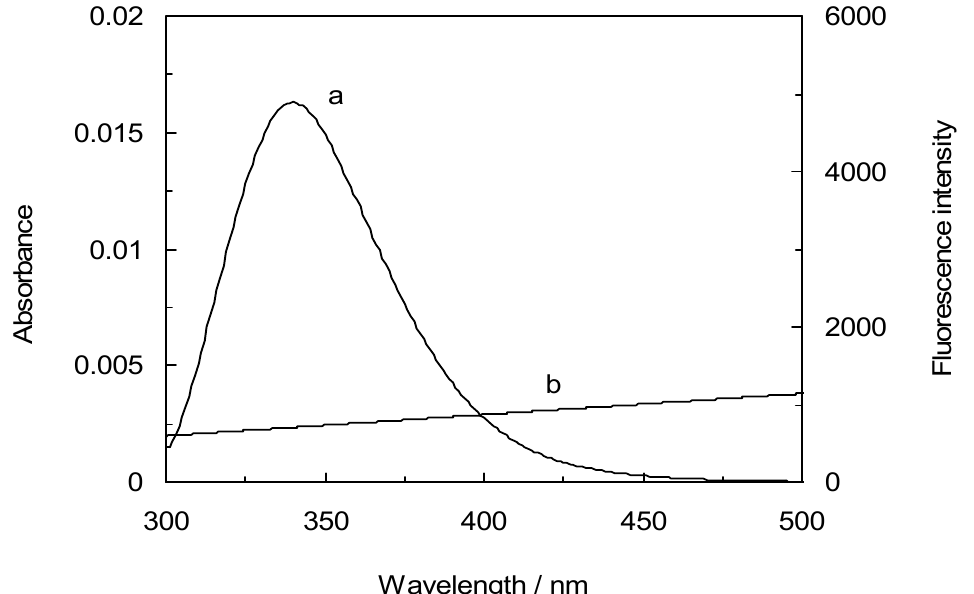
Figure 8. Spectral overlap of the fluorescence emission spectrum (curve a) of LYZ with the absorption spectrum (curve b), [LYZ] = 1 × 10 − 3 mM, [CYC] = 5 × 10 − 5 mM, [CDs] = 1 mM, pH = 7.4, T = 298